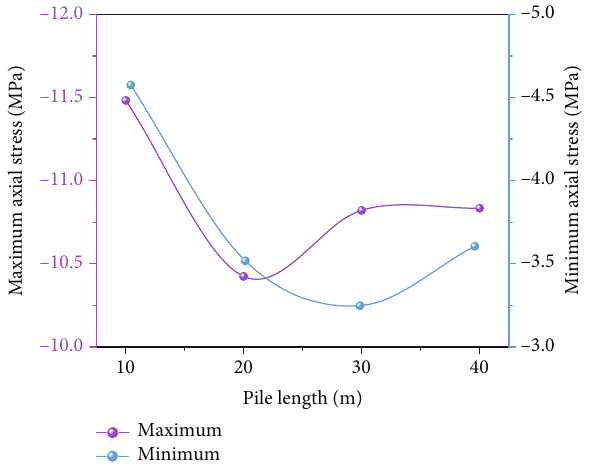
Figure 22: Variation of the maximum and minimum axial pile stresses with the pile